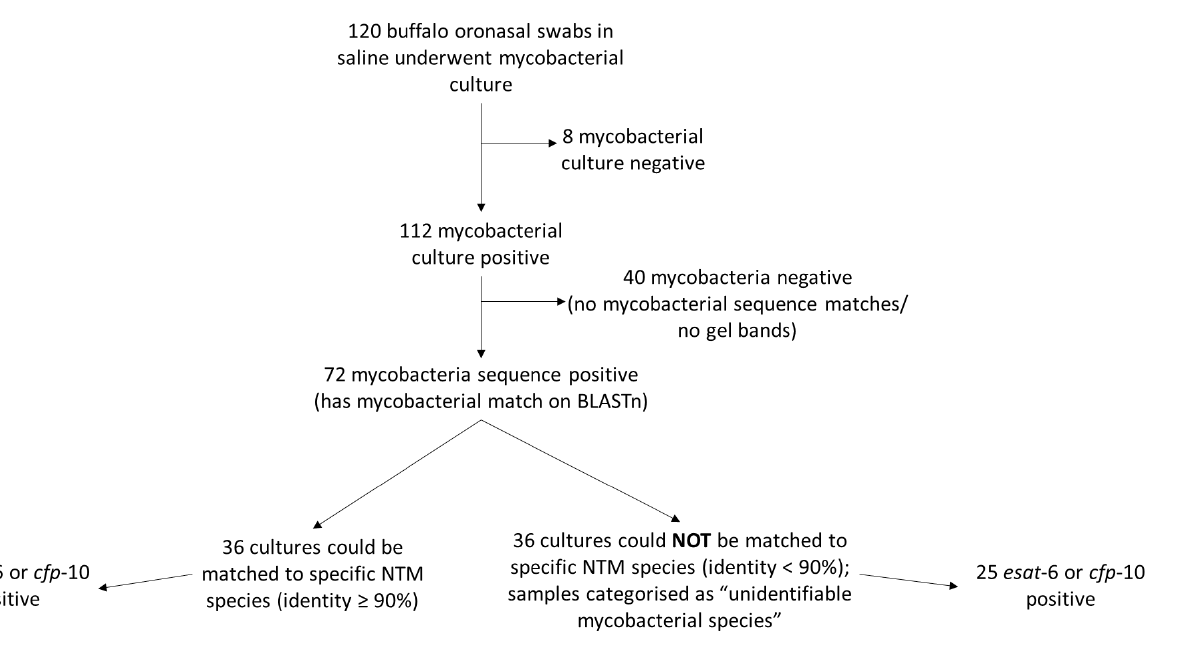
Figure 4. Flow diagram of mycobacterial culture results from buffalo oronasal swabs and Sanger sequencing results from PCRs targeting regions hsp65 and rpoB.